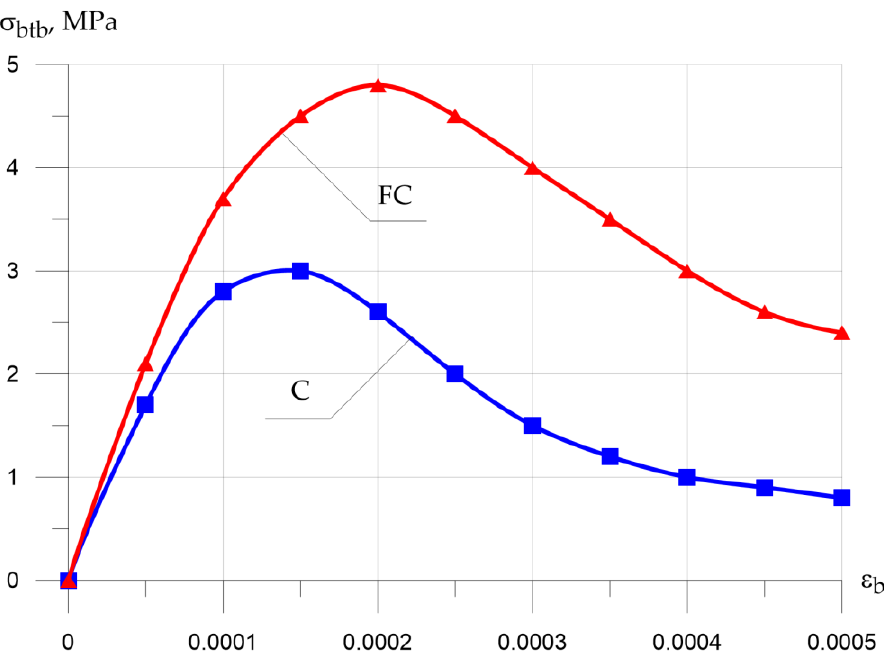
Figure 11. Stress – strain diagram for tensile concrete (C, concrete; FC, fiber-reinforced concrete). Figure 11. Stress–strain diagram for tensile concrete (C, concrete; FC, fiber-reinforced